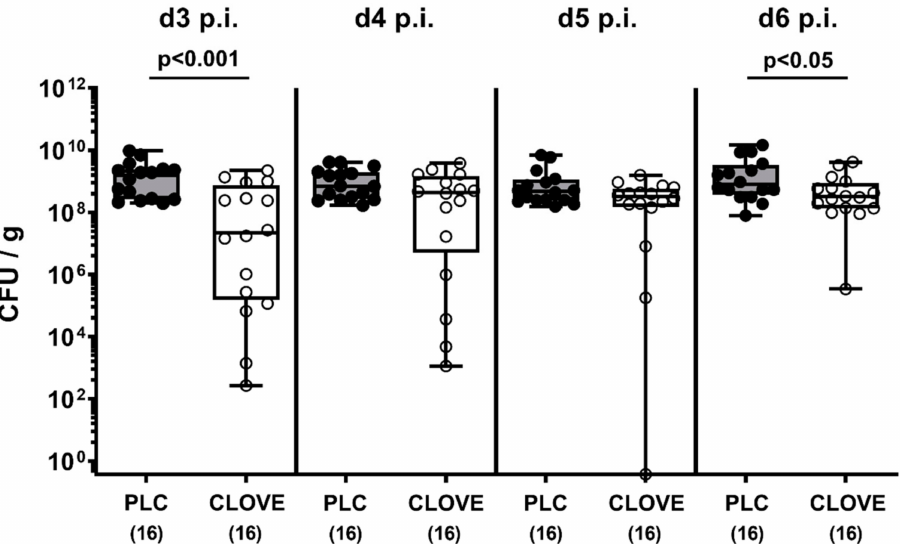
Figure 1. Kinetic survey of fecal pathogen burdens following clove essential oil (EO) treatment of Campylobacter ( C. ) jejuni infected interleukin-10 deficient (IL-10 − / − ) mice. Microbiota-depleted IL-10 − / − mice were perorally infected with C. jejuni strain 81-176 on day (d) 0 and d1. From d2 until d6 post-infection (p.i.), mice were perorally challenged with clove EO or received placebo (PLC) via drinking water. The pathogen numbers were determined in fecal samples over time by culture and expressed as colony forming units (CFU) per g). Box plots indicate the 75th and the 25th percentiles of the median (black bar within box). The total range, significance levels ( p values) determined by the Mann–Whitney U test and the total numbers of analyzed mice (in parentheses) are given. Data were pooled from four independent experiments.